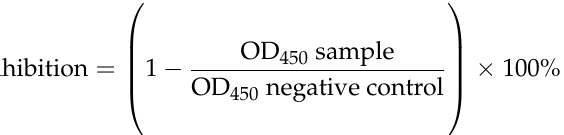
Figure 2. Timeline of the